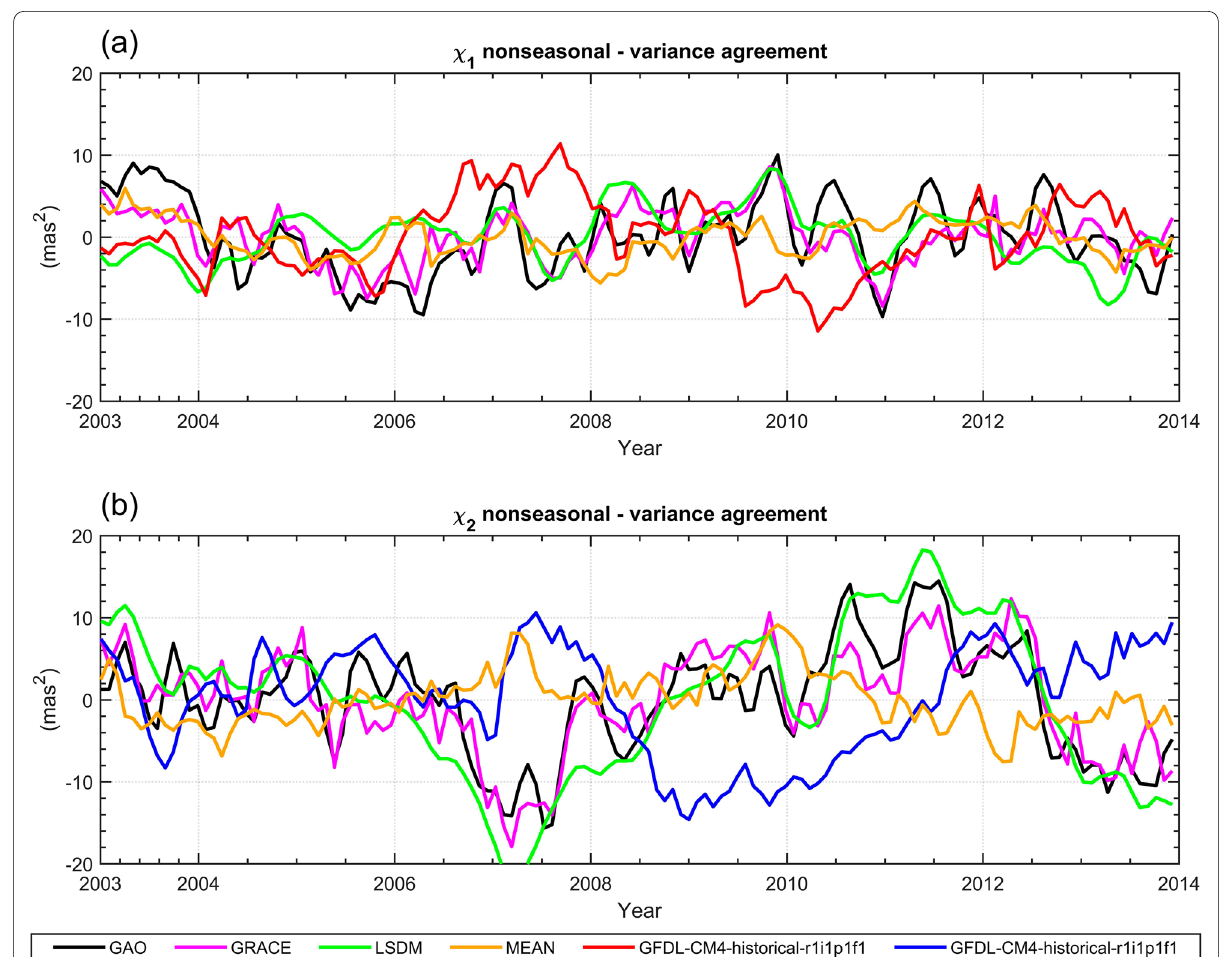
Fig. 12 The models best suited to GAO in terms of the smallest difference in variance of non-seasonal variations (red line for χ 1 in a and blue line for χ 2 in b ). The results obtained from GRACE, LSDM and MEAN model are also